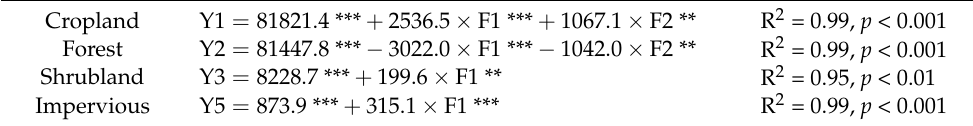
Table 6. Relationships between land-cover change and principal components in different types.